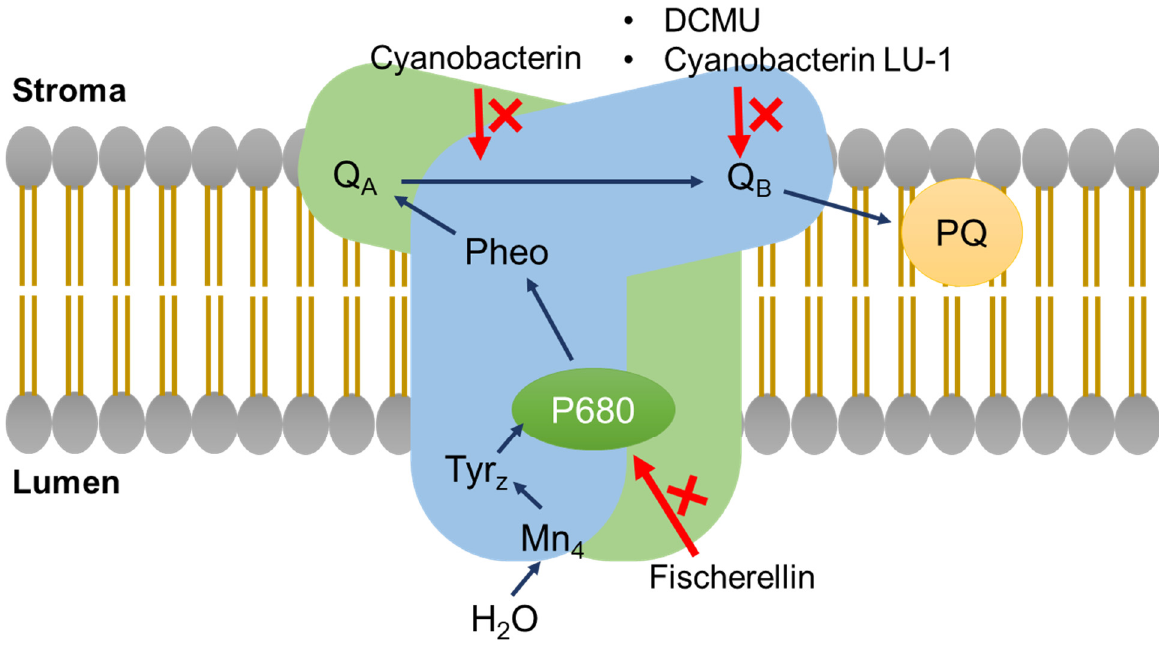
Figure 6. The mode of action of photosynthesis inhibitors as shown on a simplified diagram of photosystem II within the thylakoid membrane. QA = primary quinone acceptor; QB = secondary quinone acceptor; PQ = plastoquinone; Pheo = pheophytin; P680 = photosystem II primary donor; TyrZ = tyrosine-Z radical.